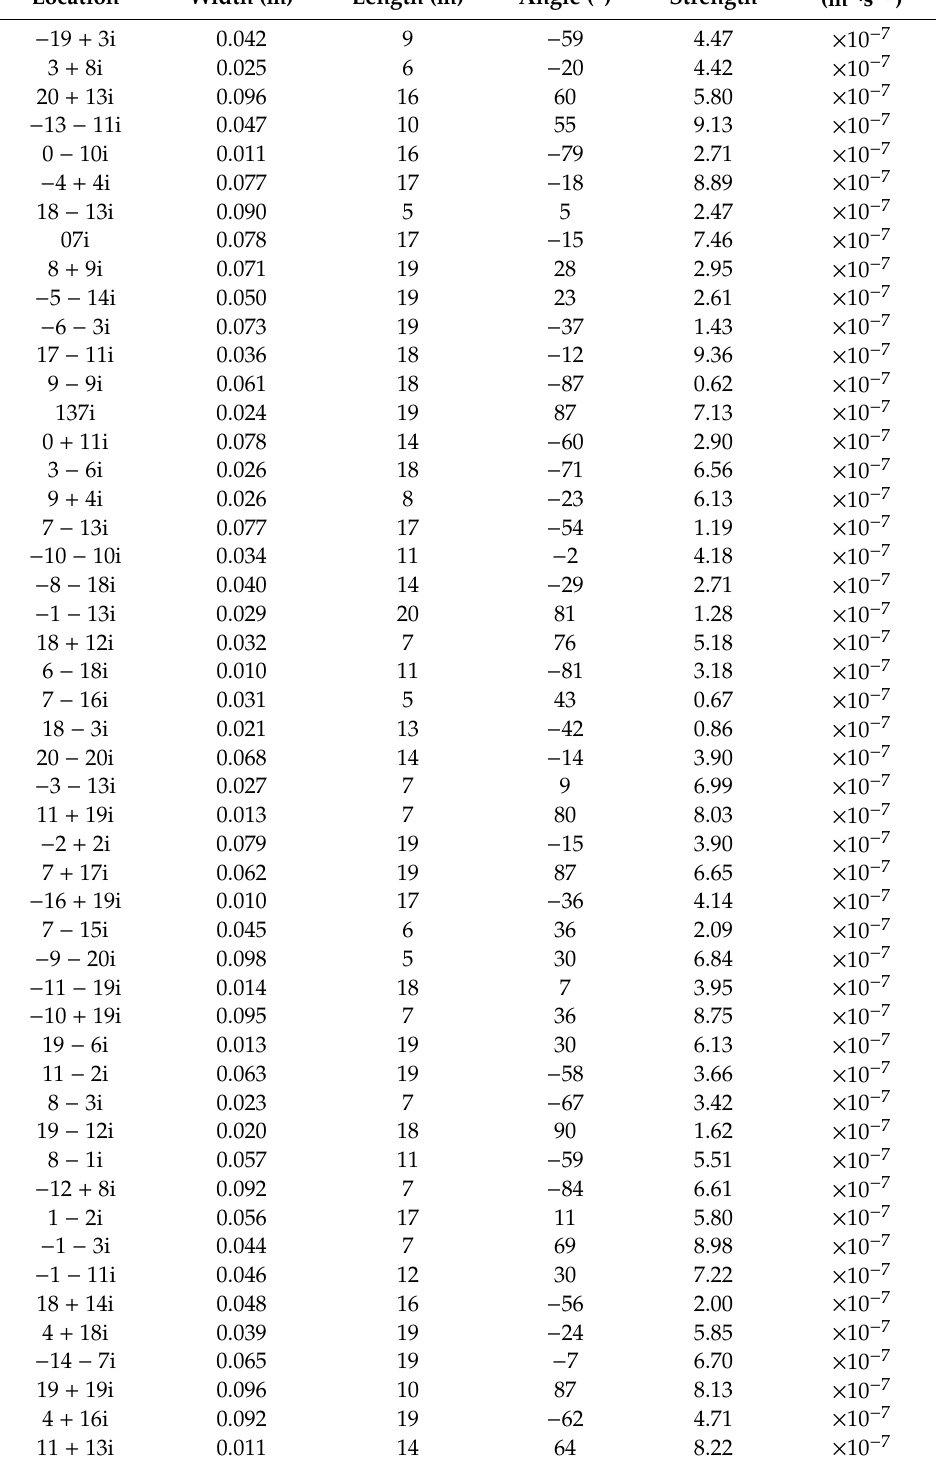
Table A6. Attributes of narrow synthetic flow channels (Case